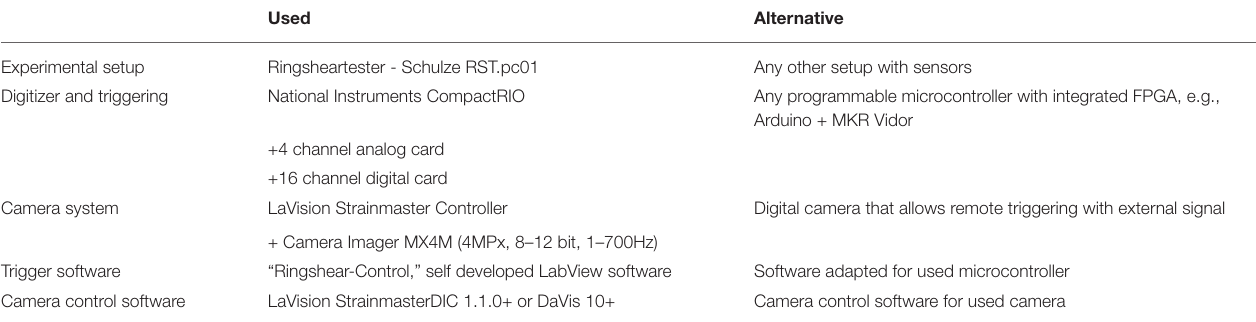
TABLE 1 | Components and input parameters needed for the triggering algorithm. Used